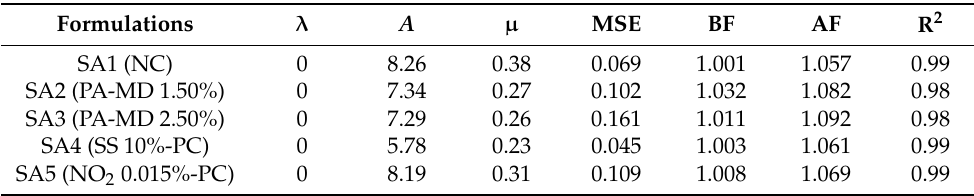
Figure 4. The effect of phytic acid-maltodextrin (PA-MD; 1.50% and 2.50%), sodium sorbate (SS; 10%), and sodium nitrite (NO 2 ; 0.015%) on C. perfringens spore development in cooked sausage (SA); PC: positive control; NC: negative control. The error bars represent the standard error ( n = 3); different lowercase letters indicate statistically significant differences by Tukey’s test among samples at the same time ( p < 0.05); different uppercase letters indicate statistically significant differences by Tukey’s test among the same sample at different times ( p < 0.05). Table 1. The growth curve parameters and statistical indices of the ML model adjustment to the experimental data of growth curves.